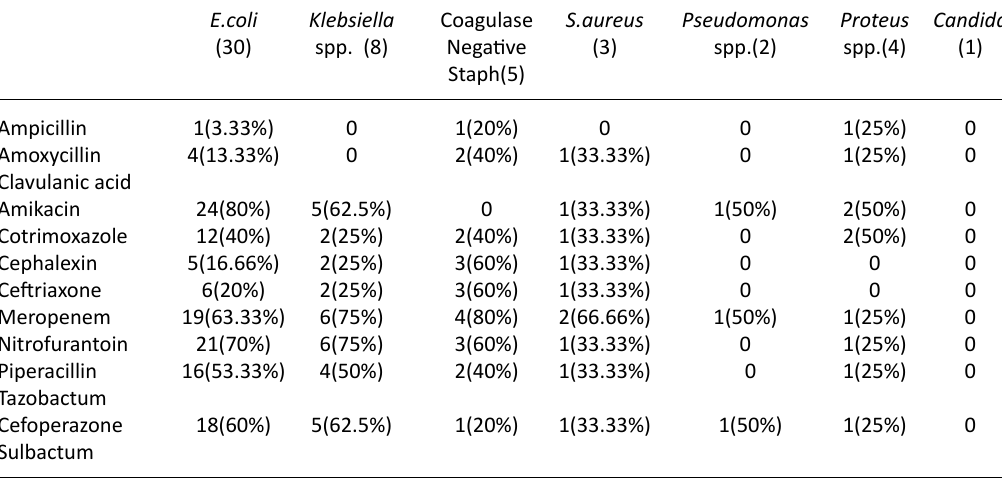
Clavulanic acid